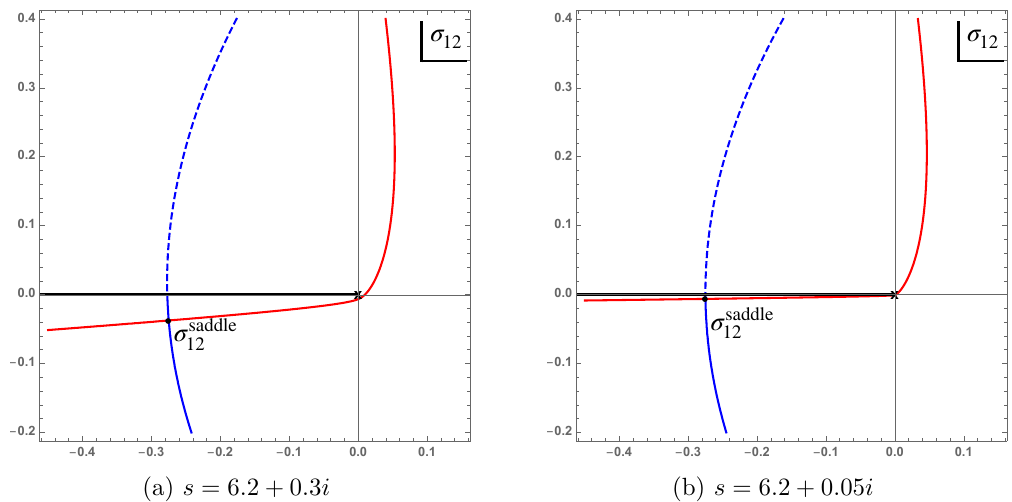
Figure 15. Steepest descent (red curve) and ascent (blue curve) contours of σ 12 integral for s = 6 . 2 + 0 . 3 i (left) or s = 6 . 2 + 0 . 05 i (right). The black dot is the saddle point, and the cross indicates the starting poles of the semi-infinite sequences of poles in Γ 2 ( Rσ 12 ) . The other poles are represented by the black solid line. As s approaches the physical region, the steepest descent contour gets close to the first Γ -function pole, but does not cross